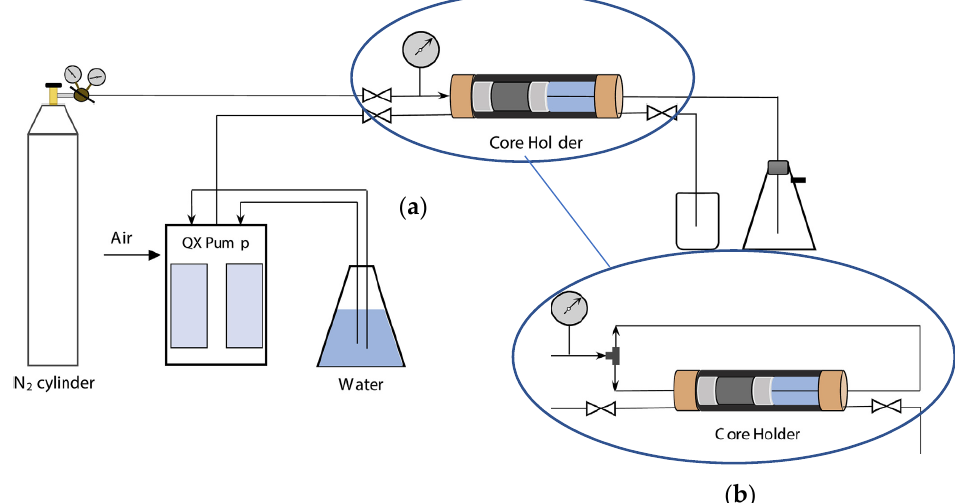
Figure 2. Schematic diagram of experimental setup for ( a ) gas flooding and ( b ) hu ff -n-pu ff gas injection. Reprint with permission [9], 2017, Elsevier.